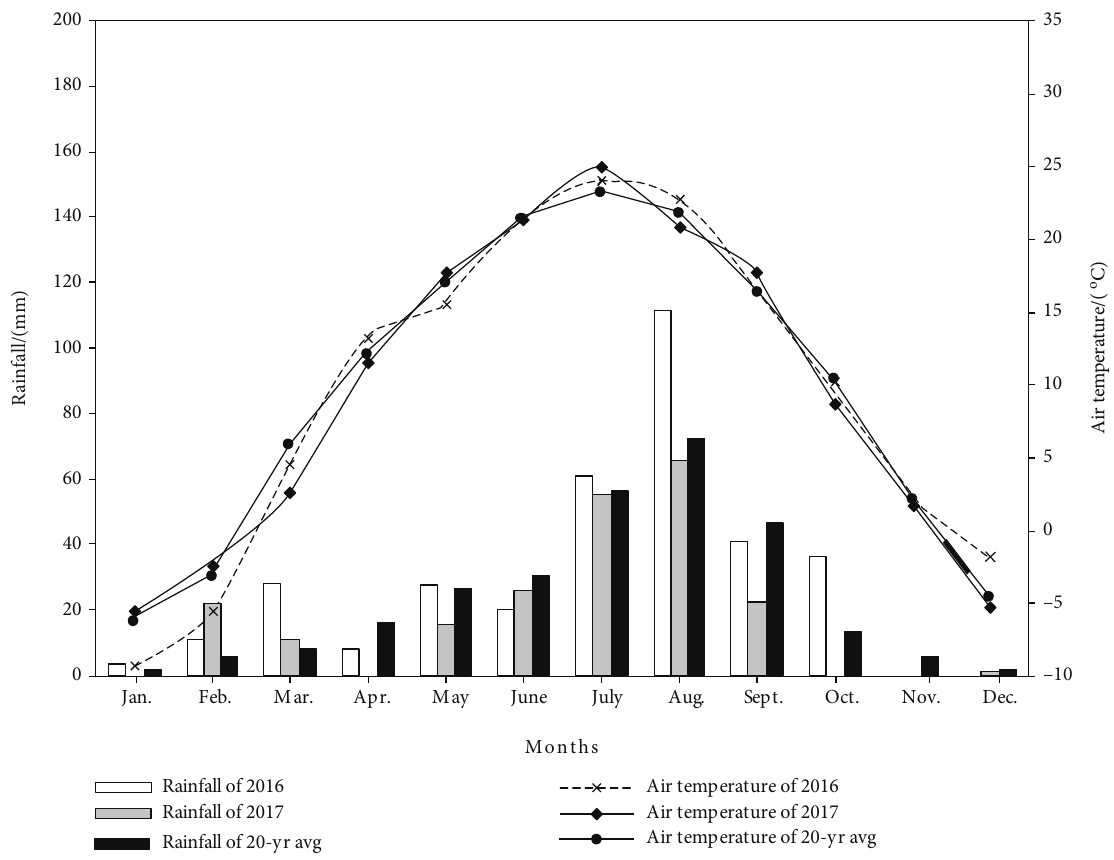
Figure 1: Monthly rainfall and average daily air temperature distribution at experimental site during the